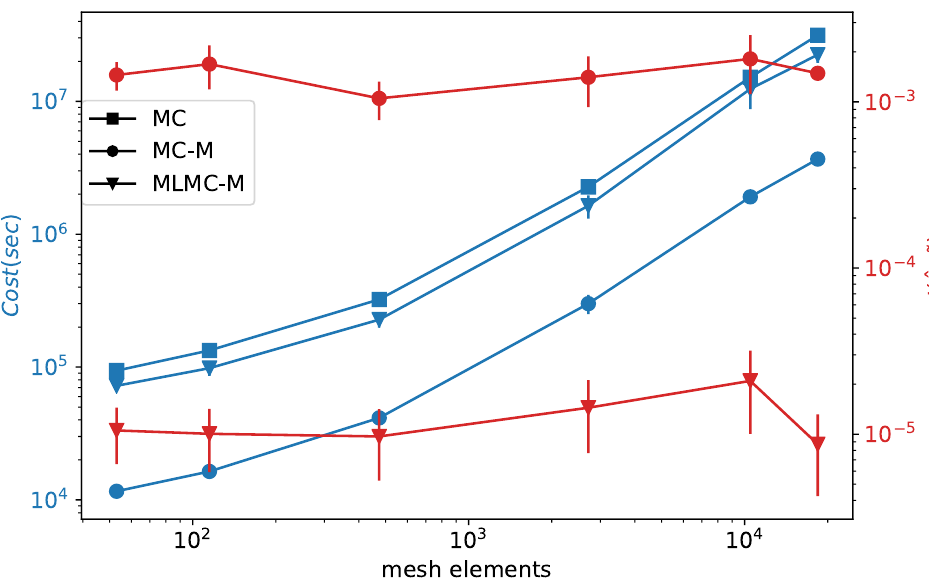
Figure 4. Cost (blue) and moments error (red) of Monte Carlo methods on six different model mesh sizes. MC (square)—standard Monte Carlo method; MC-M (circle)—standard Monte Carlo using meta-model samples; MLMC-M (triangle)—MC extended by a meta-level. J ( ˆ µ , ˜ µ ) denote error between MC moments (ˆ µ ) and MC-M or MLMC-M moments (˜ µ